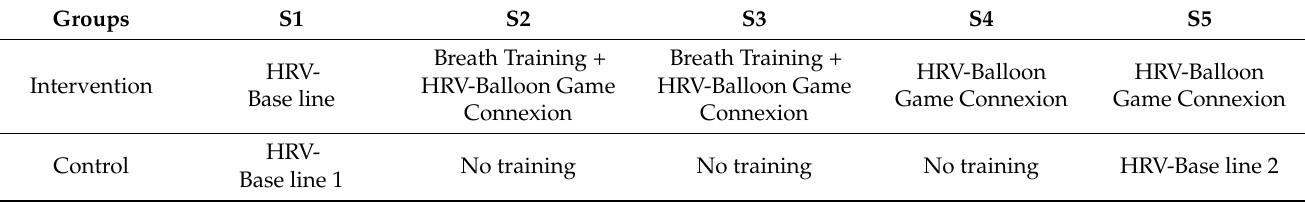
Table 1. Intervention processes for intervention and control